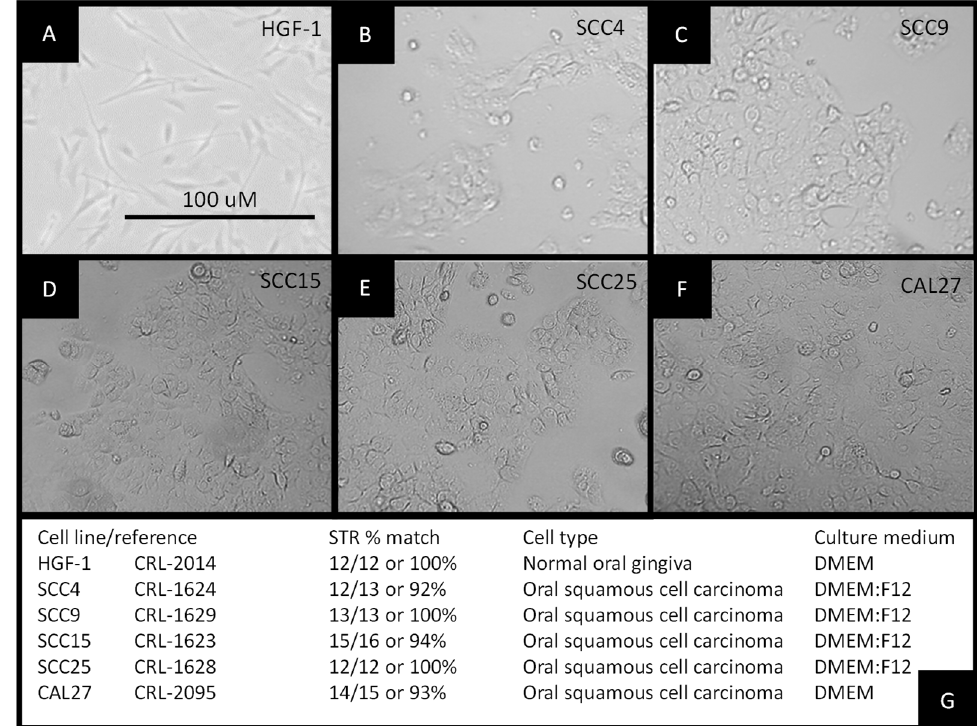
Figure 1. Establishment of experimental cell cultures: morphology of ( A ) normal, non-cancerous human gingival fibroblast HGF-1, ( B ) squamous cell carcinoma SCC4, ( C ) squamous cell carcinoma SCC9, ( D ) squamous cell carcinoma SCC15, ( E ) squamous cell carcinoma SCC25, and ( F ) squamous cell carcinoma CAL27 cells; ( G ) STR profiling was used to confirm cellular identification.